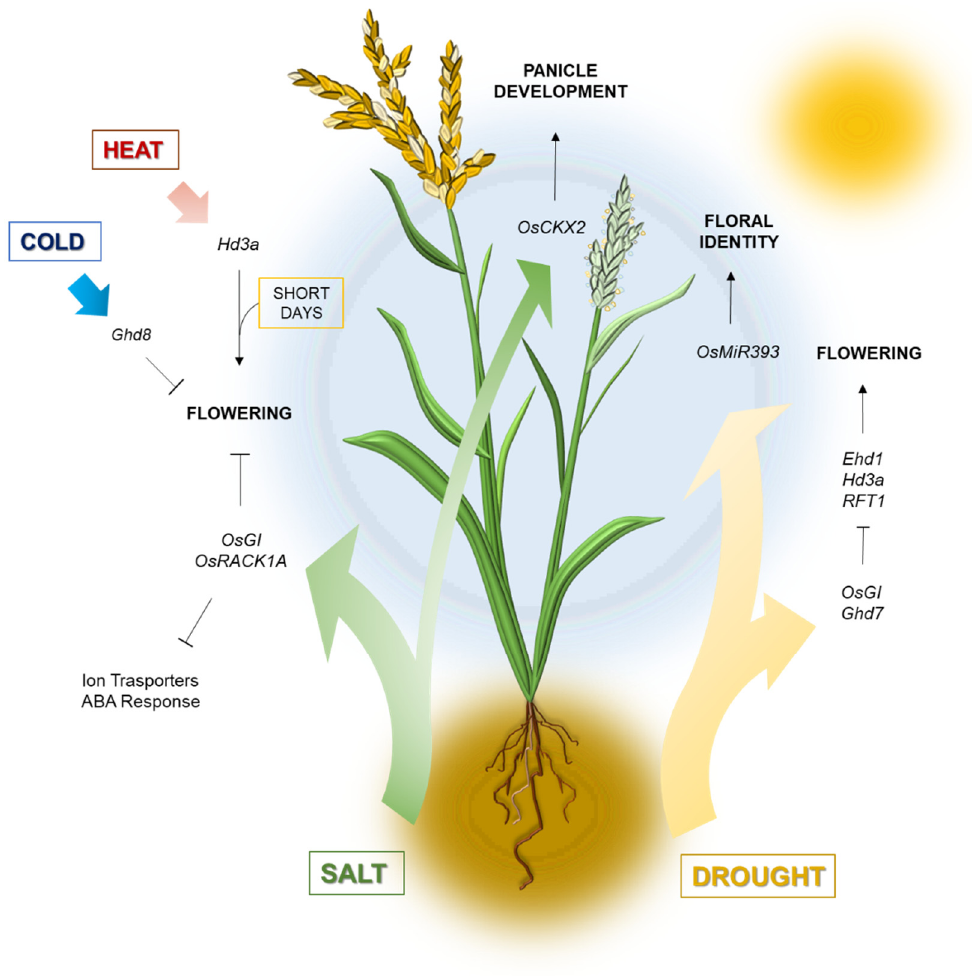
Figure 1. Rice flowering under abiotic stress. Drought, salt or extreme temperature stimuli converge on endogenous flowering regulators to modulate heading and floral organs development in Oryza sativa . Some of the major regulators involved in stress responses are indicated in italics; see text for additional details.